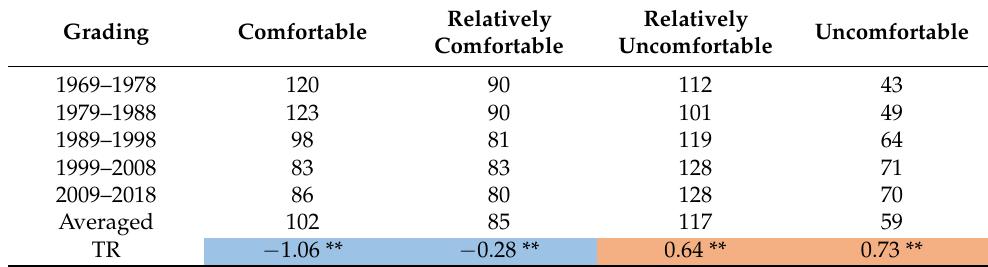
Table 4. The variation characteristics of comfort period of a comprehensive index between different years from 1969 to